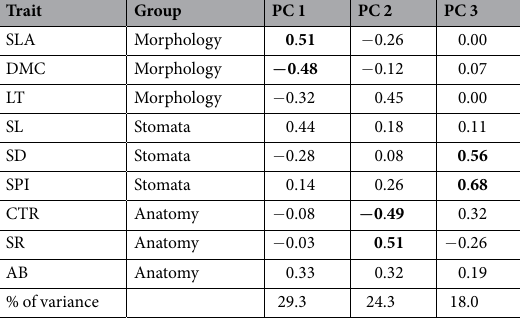
Table 3. Loading scores of nine leaf functional traits in the principal component analyses (PCA) in temperate and subtropical forests. DMC, dry matter content; SLA, specific leaf area; LT, leaf thickness; SL, stomatal pore length; SD, stomatal density; SPI, stomatal pore index; CTR, cell tense ratio; SR, spongy tissue ratio; AB, abaxial cell